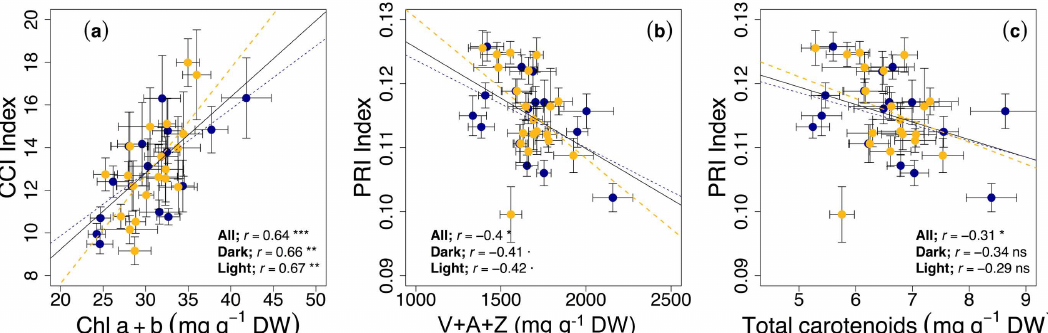
Figure 6. Relationships between ( a ) the chlorophyll content index (CCI Index) and total chlorophylls expressed on dry weight (Chl a + b; mg g − 1 DW), ( b )The photochemical reflectance index (PRI Index) and the total pool of xanthophyll cycle pigments expressed on a dry weight (mg g − 1 DW), and ( c ) the PRI Index and total carotenoids expressed on a dry weight (mg g − 1 DW), in rocket leaves during the last cycle of the entrainment phase and under continuous dark and light conditions. Values are the mean of 10 to 16 replicates ± S.E. Linear regressions are shown when significant at p < 0.05 (* p < 0.05; ** p < 0.001; *** p < 0.0001; n.s., not